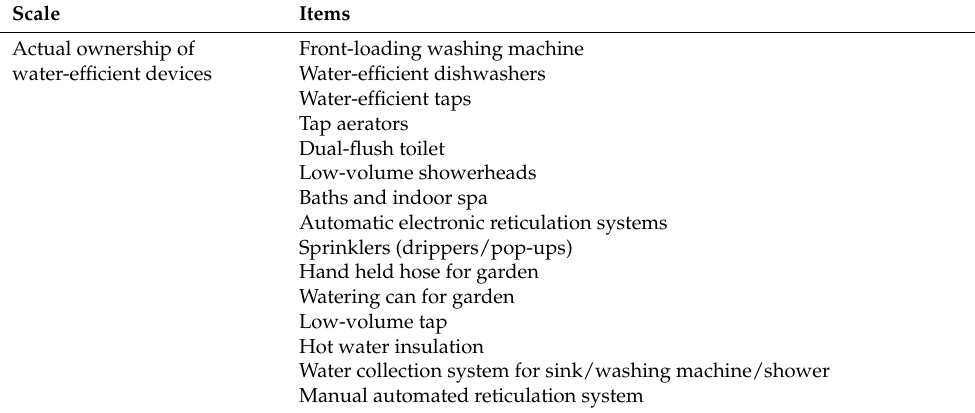
Table A2. Items used in Survey 2 assessing households’ actual water-conservation